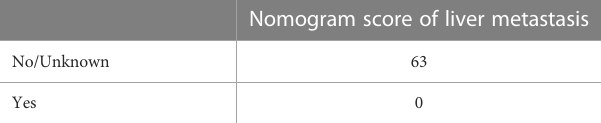
TABLE 3 Score of each clinicopathological variable in our nomogram. Nomogram score of liver